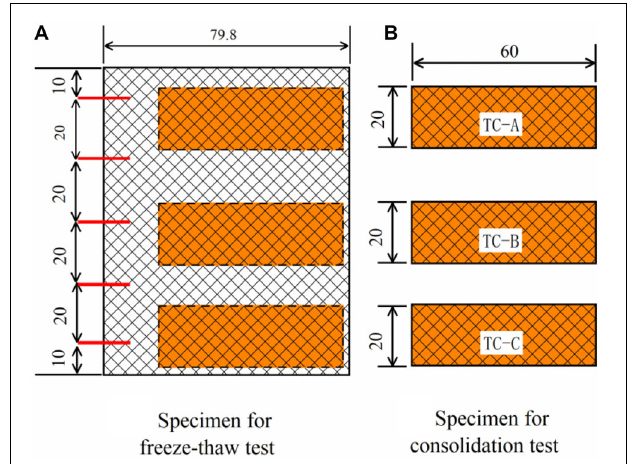
FIGURE 3 | Samples were taken along the specimen height for the consolidation test (units: mm). (A) Specimen for freeze-thaw test. (B) Specimen for Consolidation